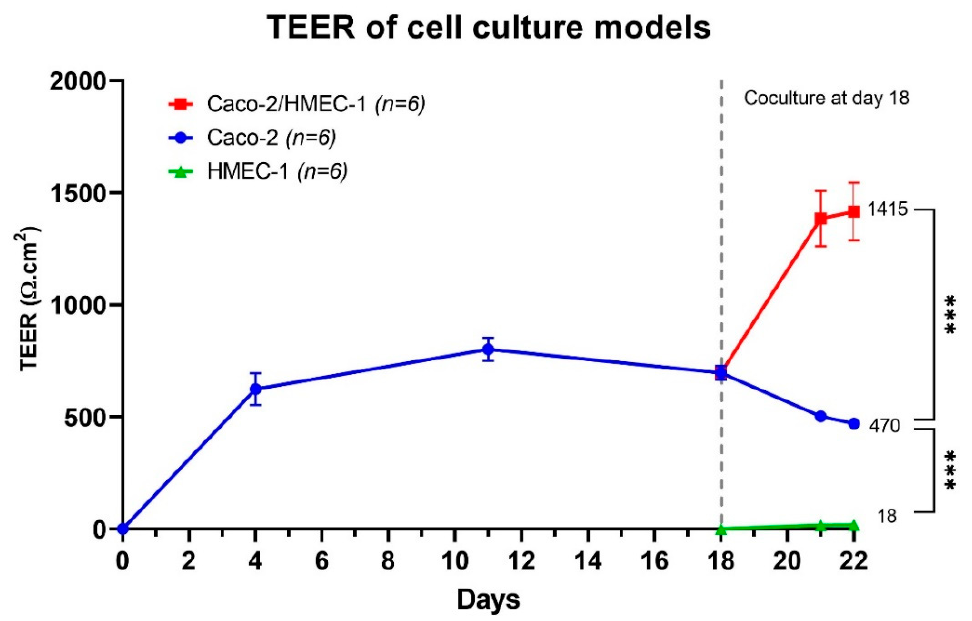
Figure 2. Average TEER ( n = 6) of Caco-2/HMEC-1 coculture (red), Caco-2 monolayer (blue), and HMEC-1 monolayer (green). The whiskers represent a 95% confidence interval (Kruskal–Wallis: *** p ≤ 0.001).